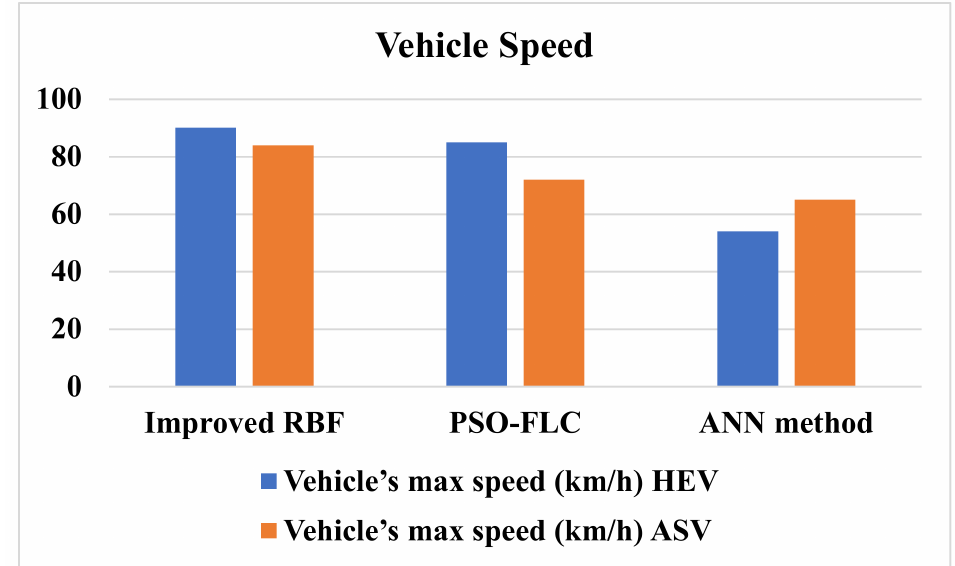
Figure 15. Comparative analysis of vehicle